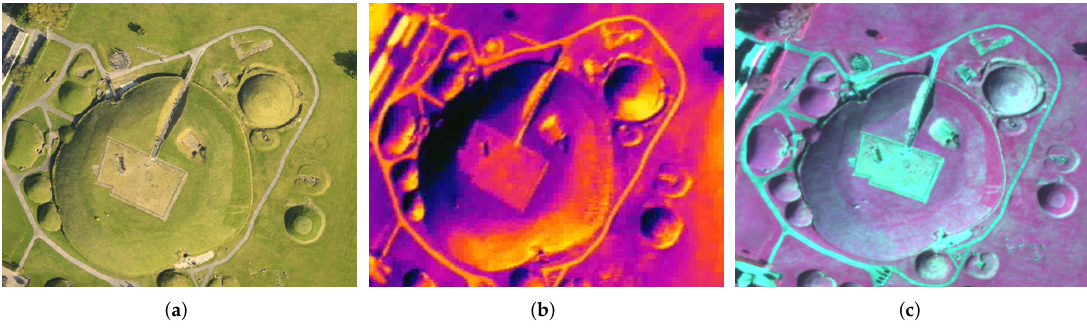
Figure 6. Sensor pods enable in-depth assessment of objects in an area by comparing multiple datasets ( a ) high resolution RGB photography enables high resolution mapping; ( b ) thermal signatures identified in the SE of the objects; ( c ) a FCC enables differentiation of vegetation type, health and land